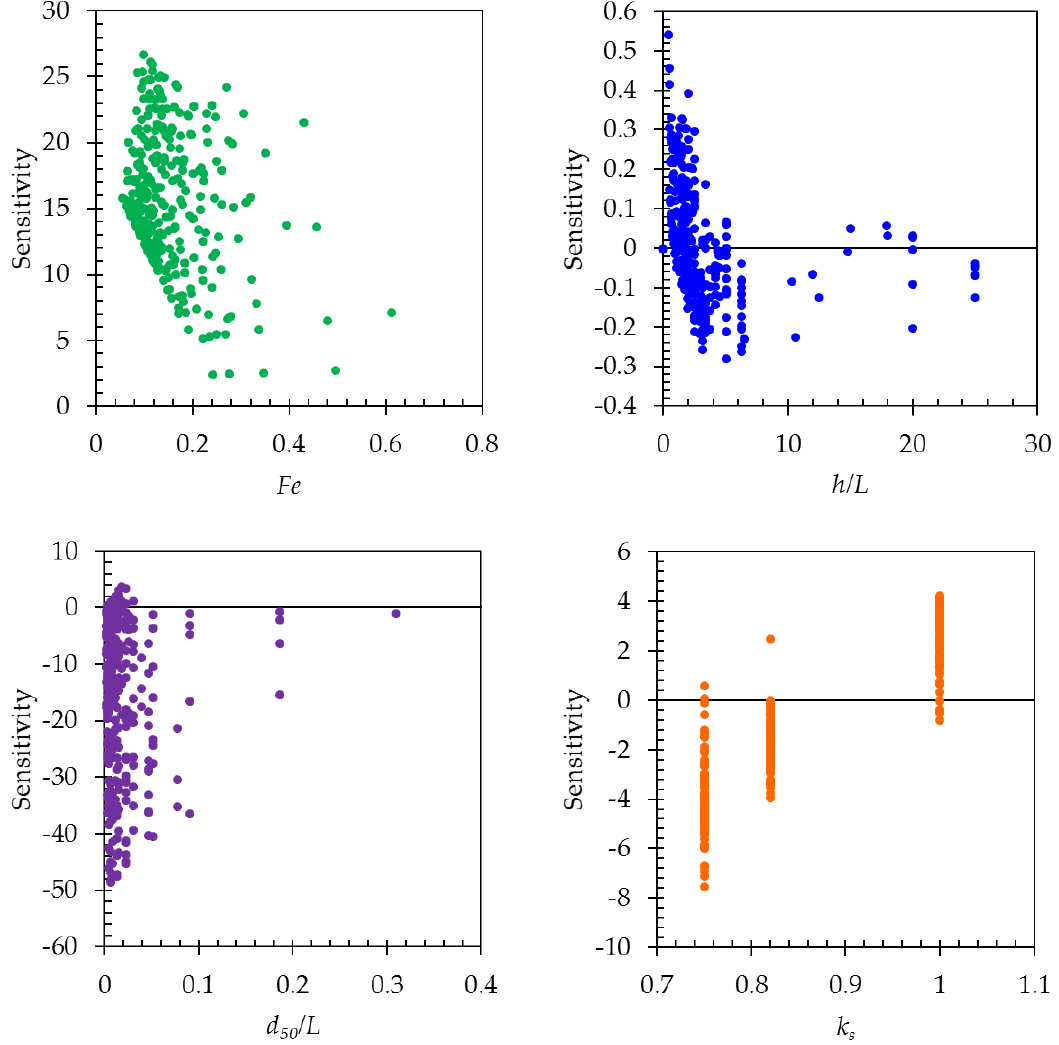
Figure 9. Partial derivative sensitivity analysis (PDSA) results for each input variable in the developed ELM-based model.